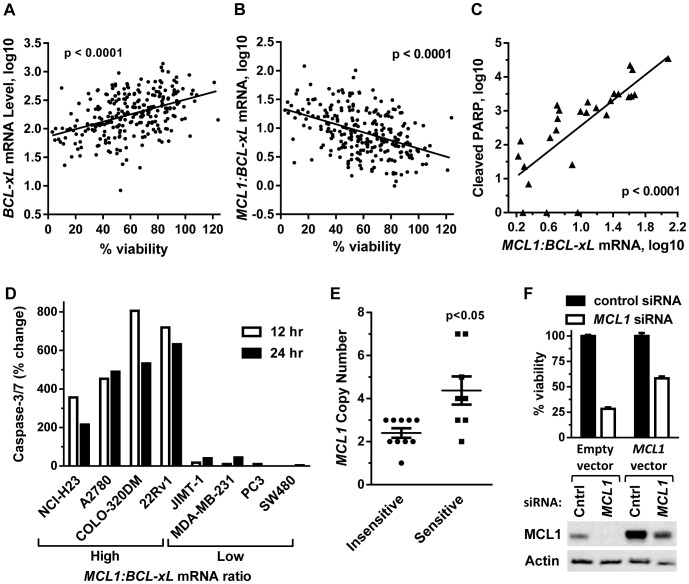
Sensitivity to short-term dinaciclib treatment correlates with BCL-xL and MCL1 levels.(A) BCL-xL mRNA level positively correlated with viability of 254 solid tumor cell lines treated 24 hr with dinaciclib (100 nM). (B) The MCL1:BCL-xL mRNA ratio negatively correlated with viability in the same dinaciclib-treated cell line panel as (A). (C) Effect of 8 hr dinaciclib (100 nM) treatment on apoptosis induction as measured by cleaved PARP fragment (y axis) against the MCL1:BCL-xL mRNA ratio (x axis). Data were measured from 27 cell lines. The MCL1:BCL-xL mRNA ratios and relative cleaved PARP fragment values for these cell lines are listed in Supplemental Table S1. Relative cleaved PARP fragments values <1 were adjusted to 1. MCL1 and BCL-xL expression values were obtained from the Broad Institute CCLE. (D) Percent change in activated caspase-3/7 levels after 12 hr (empty bars) and 24 hr (filled bars) of dinaciclib (100 nM) treatment in four high MCL1:BCL-xL mRNA ratio cell lines (COLO 320DM, 22Rv1, A2780, NCI-H23) and four low MCL1:BCL-xL mRNA ratio cell lines (MDA-MB-231, JIMT-1, SW480, PC3). (E) Effect of MCL1 copy number on viability after 24 hr, 100 nM dinaciclib treatment in 18 cell lines. Insensitive cell lines (circles) exhibited ≥70% cell viability and sensitive cell lines (squares) exhibited <30% cell viability after dinaciclib treatment. (F) MCL1 rescue of siRNA knockdown in NCI-H23 cells. Top, percent cell viability remaining in cells transfected with empty vector control or vector expressing MCL1 lacking 3′ UTR, followed by 24 hr transfection with control siRNA (filled bar) or MCL1 siRNA targeting 3′ UTR of endogenous MCL1 (empty bar). Bottom, MCL1 immunoblot of NCI-H23 cells described in top panel. Cntrl  =  Control.